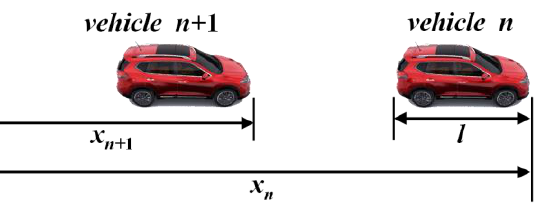
Figure 1. Schematic diagram of the car-following model.